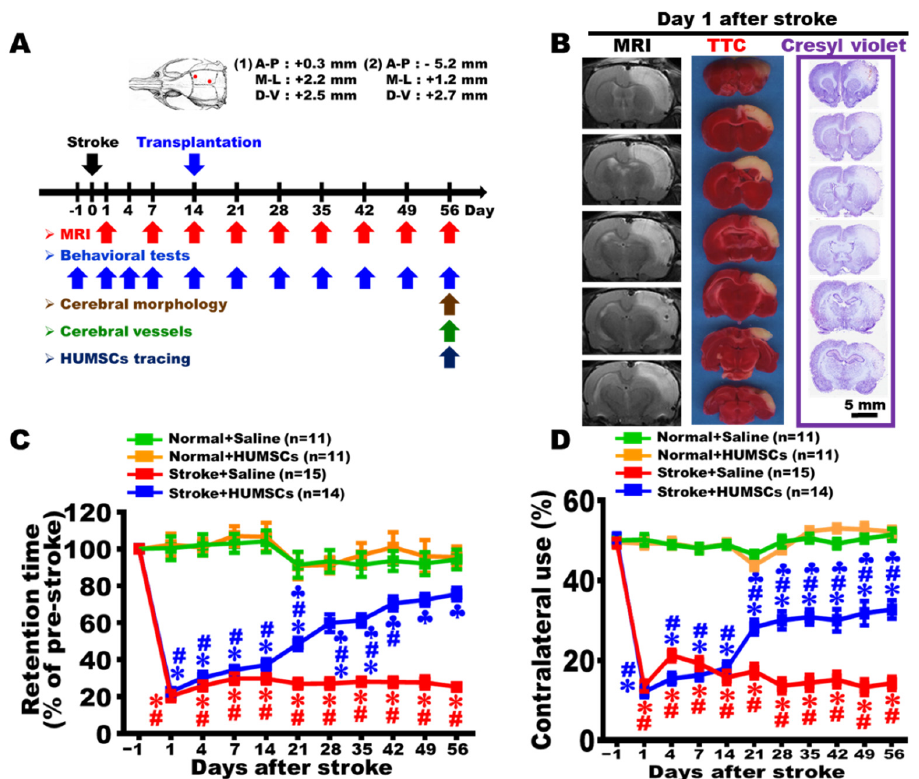
Figure 1. HUMSCs transplantation enhanced motor function in rats with chronic stroke. ( A ) The diagram shows the time course for various experiments in this study. Representative MRI, TTC- stained, and cresyl violet stained images of rat brains are shown on day 1 after stroke, showing that right cerebral cortices were markedly enlarged ( B ). The Stroke + HUMSCs group show better functional recovery in the rotarod test ( C ) and cylinder test ( D ) than the Stroke + Saline group. Normal + Saline n = 11, Normal + HUMSCs n = 11, Stroke + Saline n = 15, Stroke + HUMSCs n = 14. ∗ , vs. the Normal + Saline group at the same day, p < 0.05. #, vs. the Normal + HUMSCs group at the same day, p < 0.05. ♣ , vs. the Stroke + Saline group at the same day, p < 0.05.